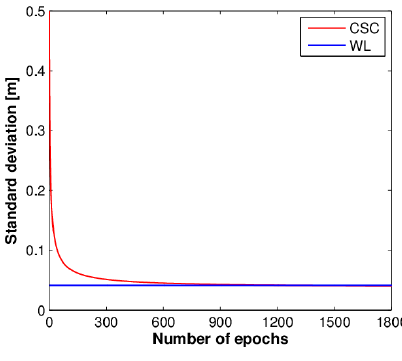
Figure 1. Standard deviation of CSC measurements and WL measurements versu s the number of epochs.